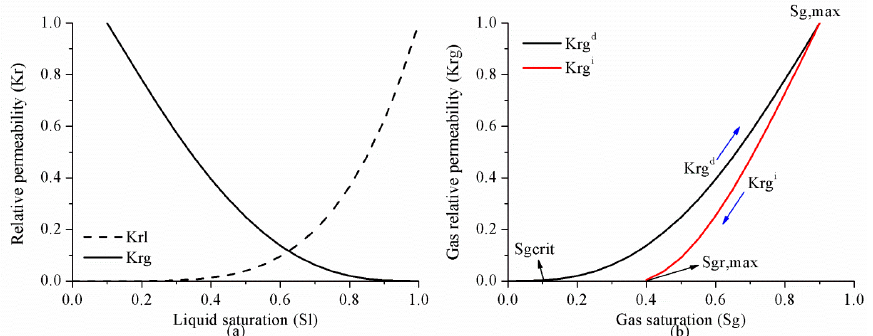
Figure 2. ( a ) Corey’s model and ( b ) Land’s trapping model.